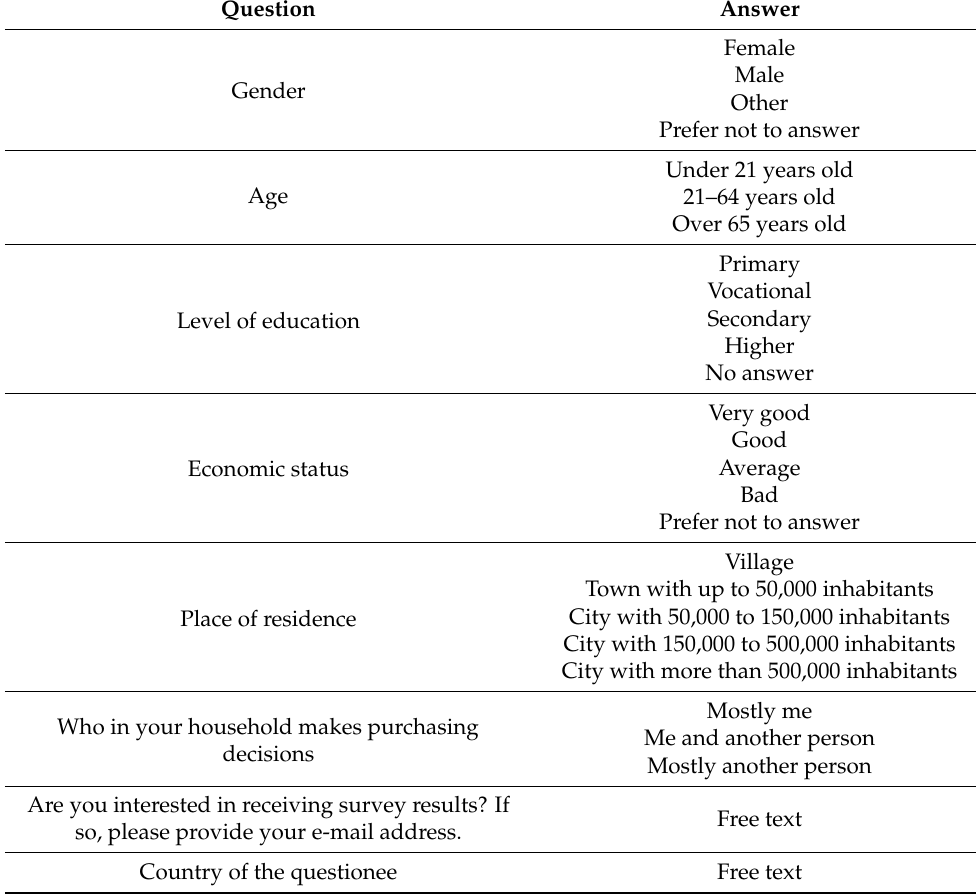
Table 1. The list of questions and available answers of the online